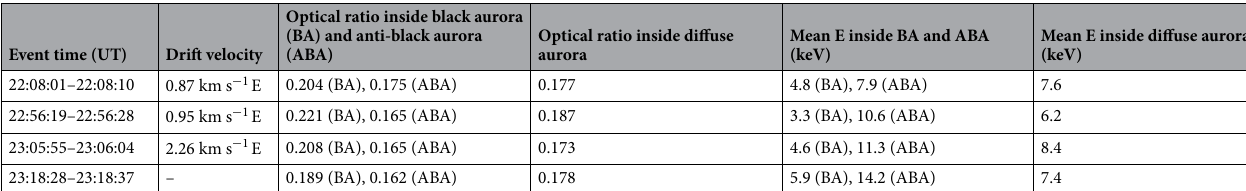
Table 1. Table showing the times (column 1) and drift velocities (column 2) of the selected anti-black aurora (ABA) and black aurora (BA) paired events recorded on 12 March 2016. Only three events had measurable + drift speeds. Optical ratios (I(O)/I( N 2 )) inside and outside the BA and ABA events are shown in columns 3 and 4, respectively. Likewise, the mean energies inside and outside the BA and ABA are shown in columns 5 and 6,